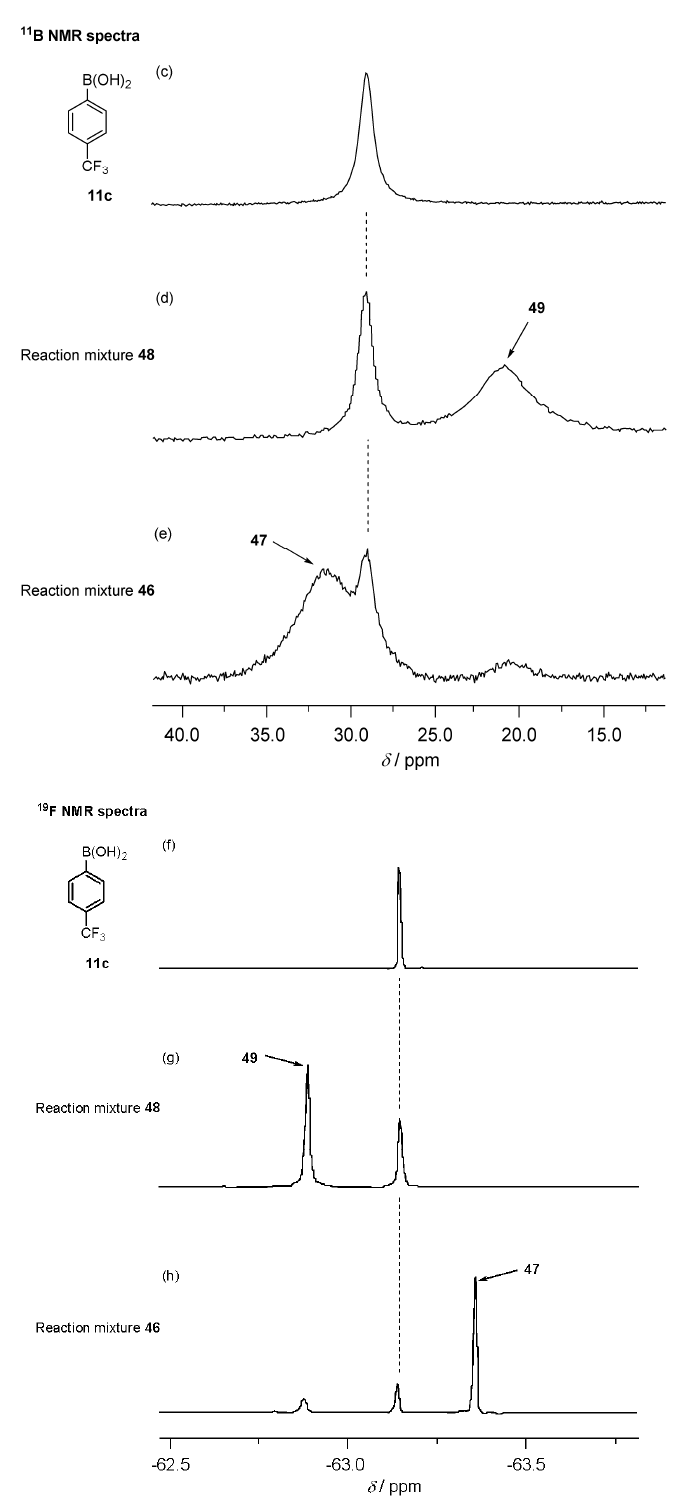
Figure 3. Possible assignment of intermediates from the reaction of uridine 10 and 4-CF 3 PhB(OH) 2 11c in 1 H, 11 B and 19 F NMR spectra (in CD 3 CN at 25 °C). ( a ) 1 H NMR of 10 ; ( b ) 1 H NMR of a mixture 46 ; ( c ) 11 B NMR of 11c ; ( d ) 11 B NMR of a mixture 48 ; ( e ) 11 B NMR of a mixture 46 ; ( f ) 19 F NMR of 11c ; ( g ) 19 F NMR of a mixture 48 ; ( h ) 19 F NMR of a mixture 46 .